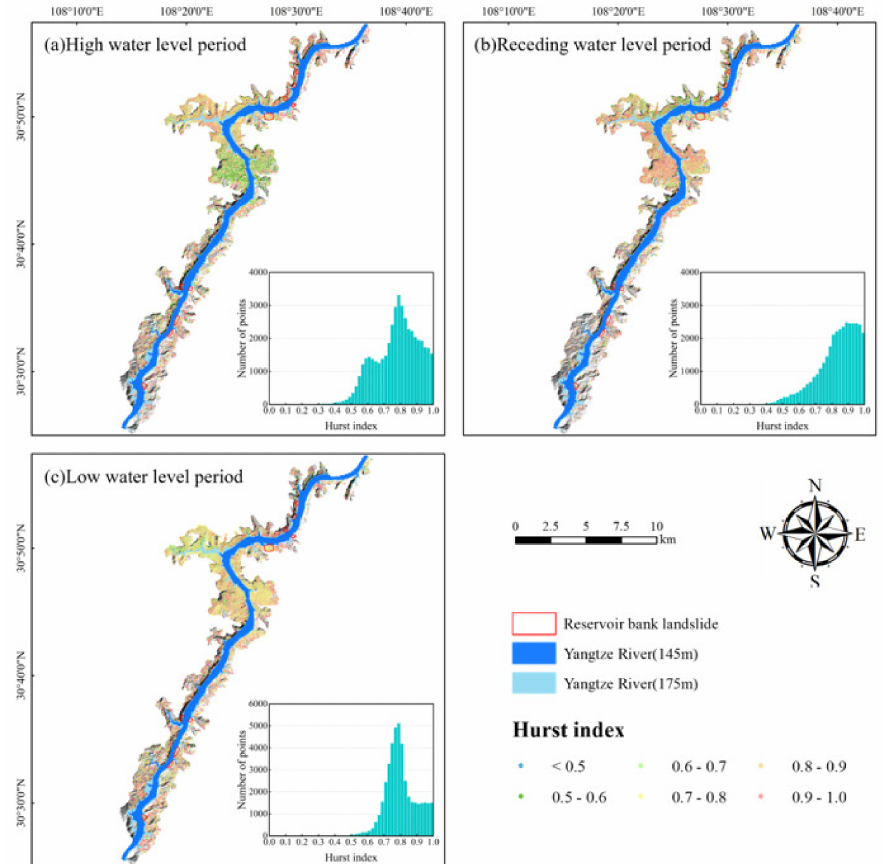
Figure 12. Spatial distribution and statistical distribution of Hurst index values in different water level periods: ( a ) 2020.11–2021.2 high water level period; ( b ) 2021.3–2021.6 receding water level period; and ( c ) 2021.7–2021.10 low water level